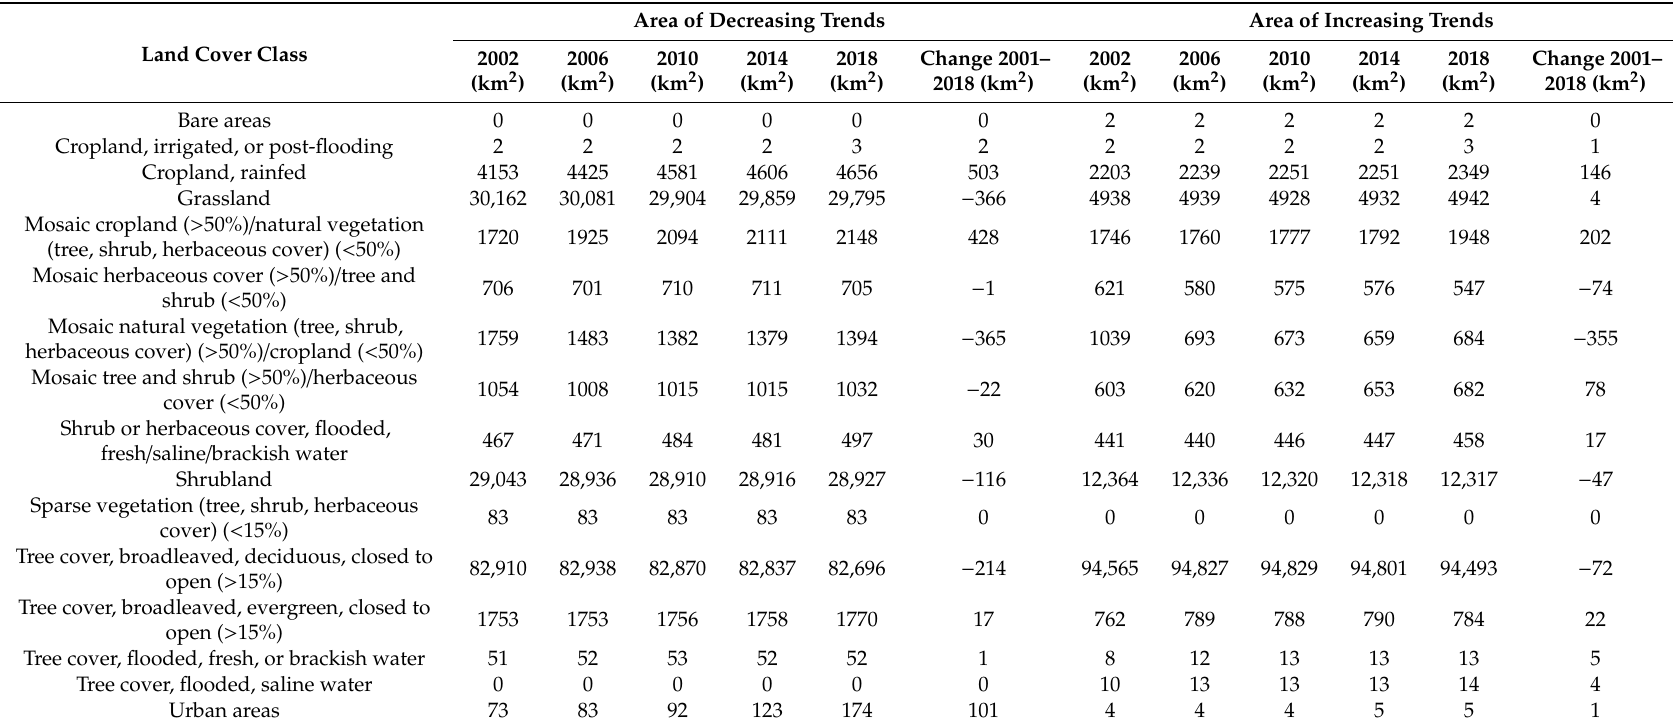
Table 2. Area of land cover classes within the significant clusters of burnt area trends, in 2002, 2006, 2010, 2014, and 2018.